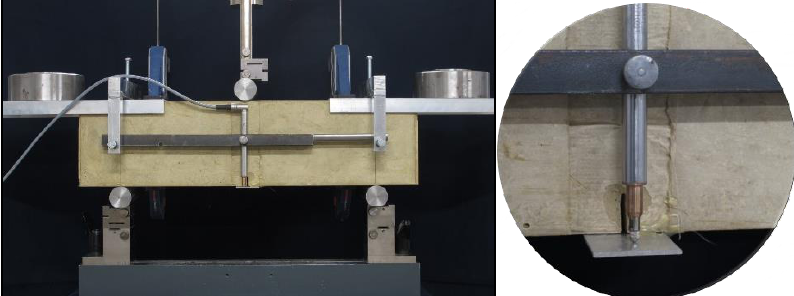
Figure 4. Specimen viewed from the other side during the test—deflection d measured using a displacement transducer.